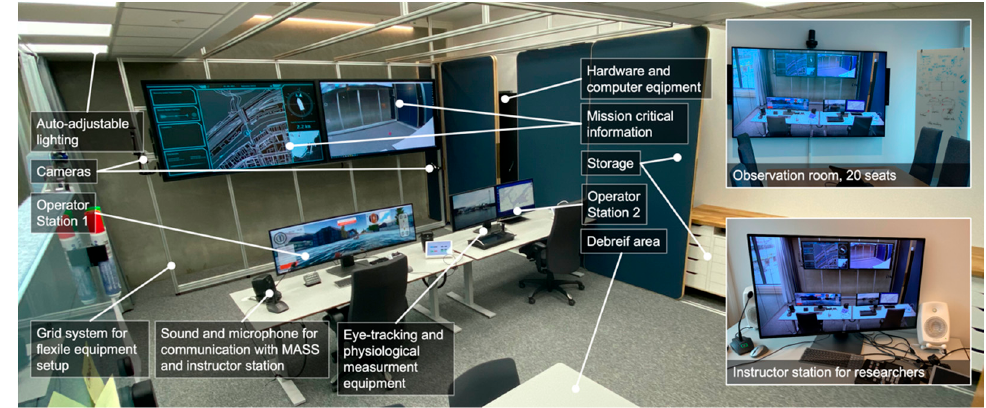
Figure 11. The NTNU Shore Control Lab is designed to enhance human perception and decision-making for ASV opera- tion in out-of-the-ordinary situation handling (see [43,44] for details).